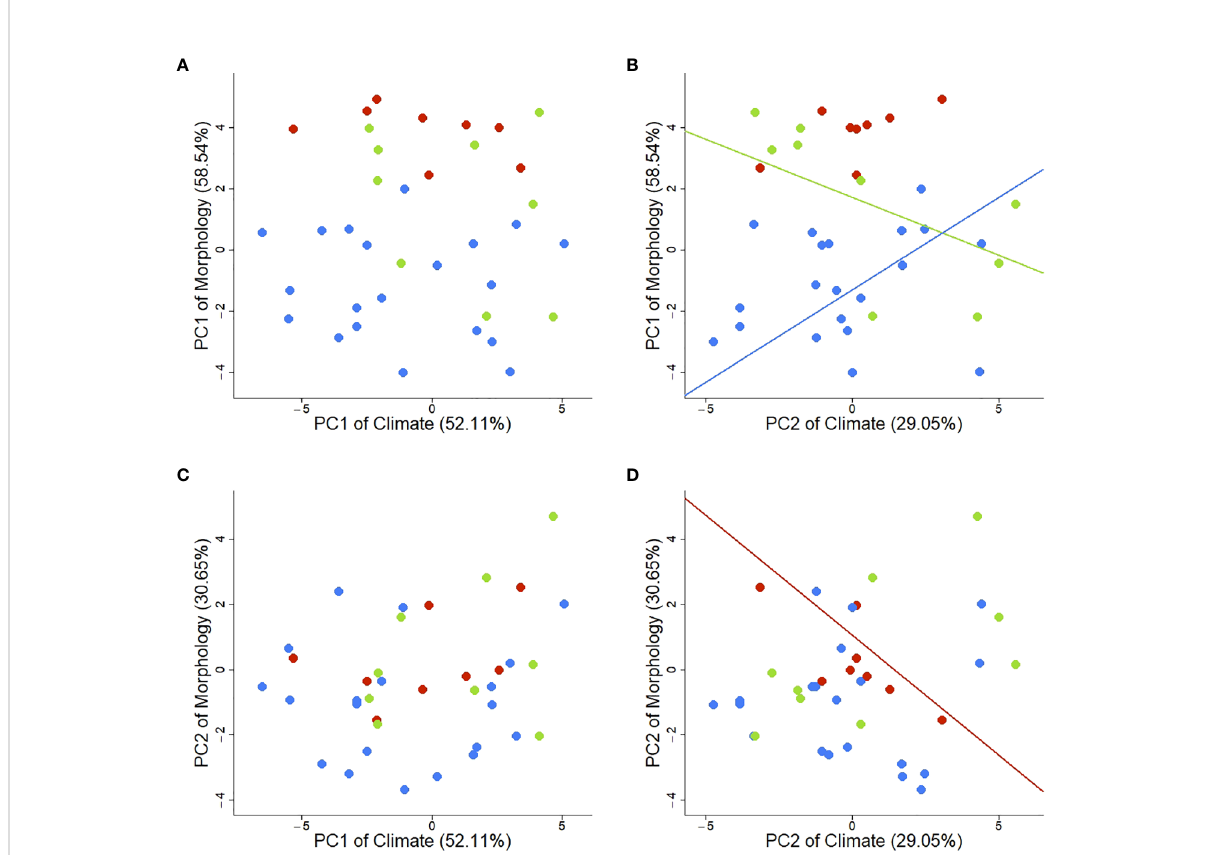
FIGURE 5 Interactions and PGLS regressions between fi rst and second components of climatic and morphological spaces. (A) PC1 of Climate and PC1 of Morphology. (B) PC2 of Climate and PC1 of Morphology (BR: Intercept = 1.727, p = 0.025; Slope = -0.380, p = 0.037; SS: Intercept = -1.302, p < 0.001, Slope = 0.604, p = 0.009). (C) PC1 of Climate and PC2 of Morphology. (D) PC2 of Climate and PC2 of Morphology (MR: Intercept = 1.057, p = 0.404; Slope = -0.735, p = 0.029). Lines represent statistically signi fi cant regressions ( p < 0.05). Colors indicate different growth forms: green – BR (branching rosettes), red – MR (monocarpic rosettes), blue – SS (shrubs or